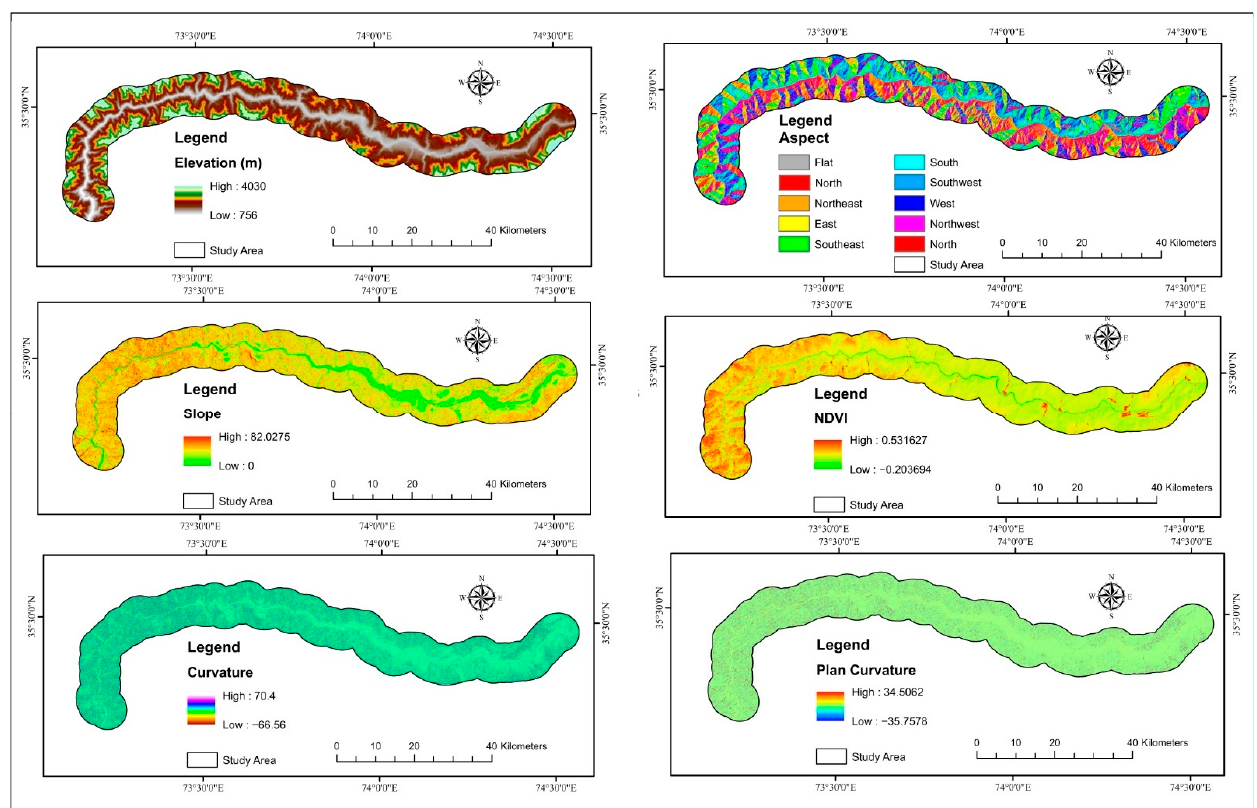
Figure 6 . Landslides factors used in the research study. Figure 6. Landslides factors used in the research